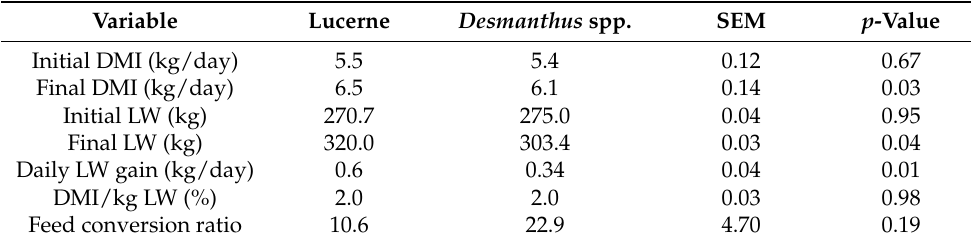
Table 4. Initial and final DMI, LW, daily gains, and feed conversion ratio of steers fed lucerne and Desmanthus spp.